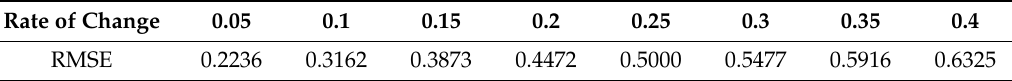
Table 7. RMSE calculation results of variations in head for Scenario